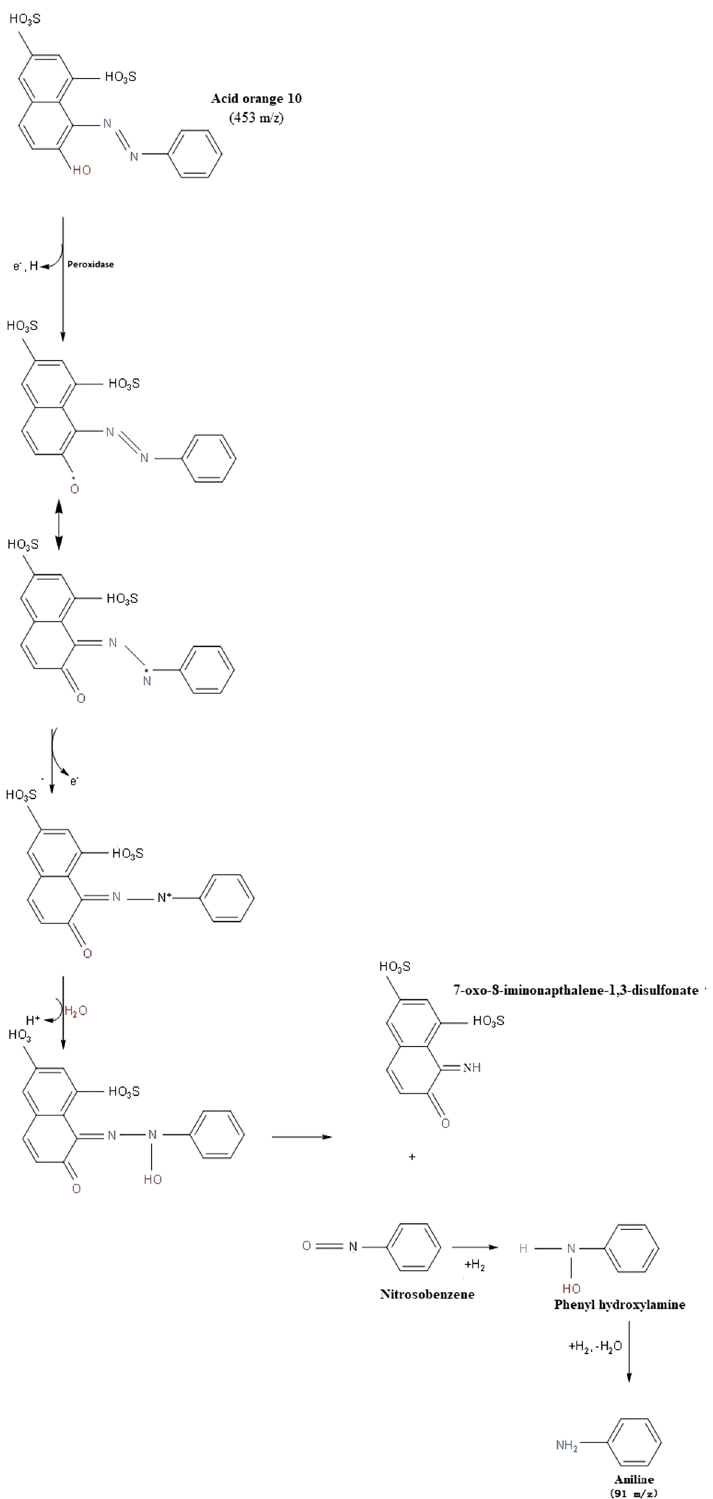
Figure 3. Proposed pathway for degradation of acid orange 10 dye by G. candidum (Images have been drawn using the software KingDraw (v1.1.0, http:// www. kingd raw. cn/ en/ downl oad.